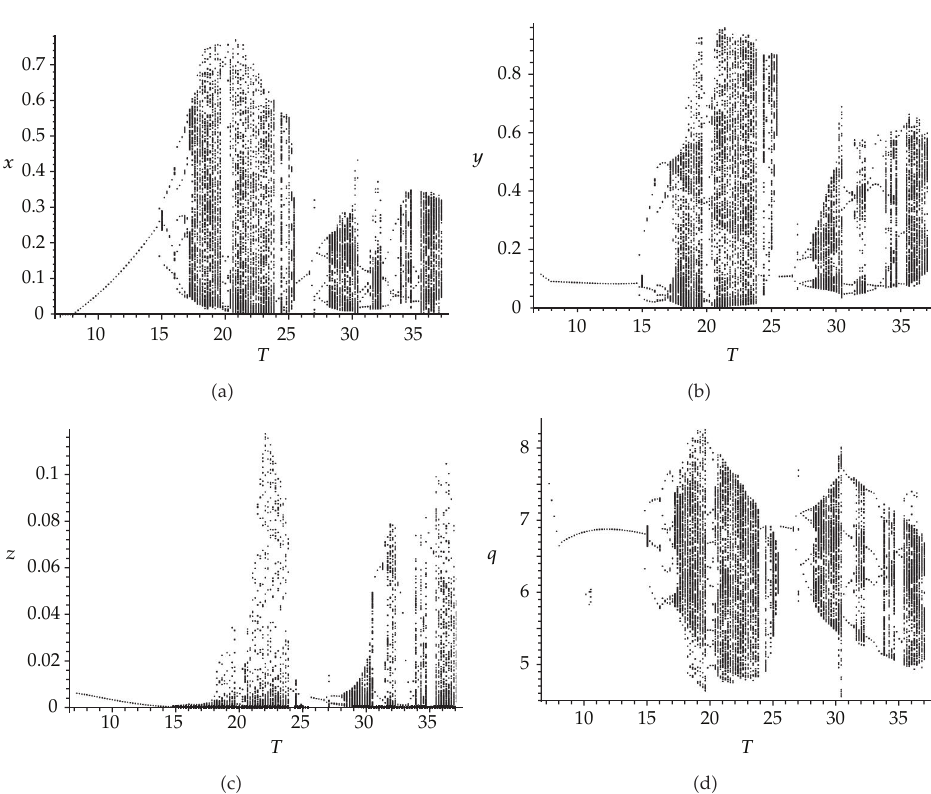
Figure 2: Bifurcation diagram of system (cid:2) 1.3 (cid:3) with initial conditions x (cid:2) 0 (cid:3) (cid:7) 0 . 1 ,y (cid:2) 0 (cid:3) (cid:7) 0 . 2 ,z (cid:2) 0 (cid:3) (cid:7) 0 . 3 ,q (cid:2) 0 (cid:3) (cid:7) 0 . 4, 7 ≤ T ≤ 37, b (cid:7) 6, d (cid:7) 3, c (cid:7) 3, e (cid:7) 0 . 2, f (cid:7) 2, g (cid:7) 2 . 5, h (cid:7) 0 . 1, m (cid:7) 2; j (cid:7) 0 . 1, k (cid:7) 0 . 6, l (cid:7) 0 . 01, a (cid:7) 3, and p (cid:7) 0 .